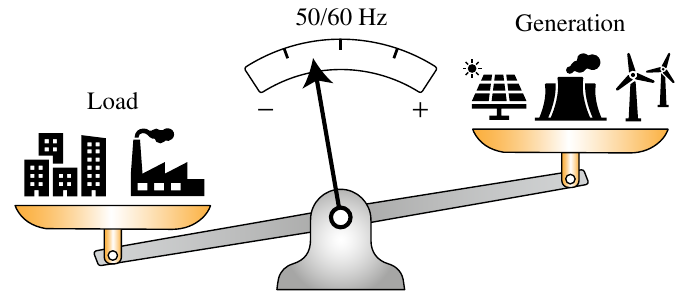
Figure 2. Qualitative representation of the electrical system power balance and its effect on the grid frequency. The power injected by generators is controlled to keep the frequency at its rated